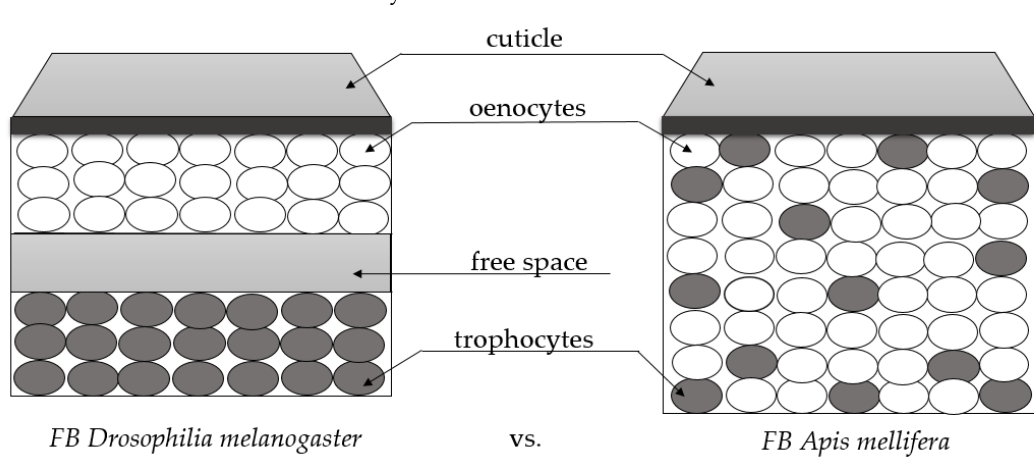
Figure 2. Differences in the structure of the subcuticular fat body (FB) between the fly ( D. melanogaster ) and bee ( A. mellifera ).